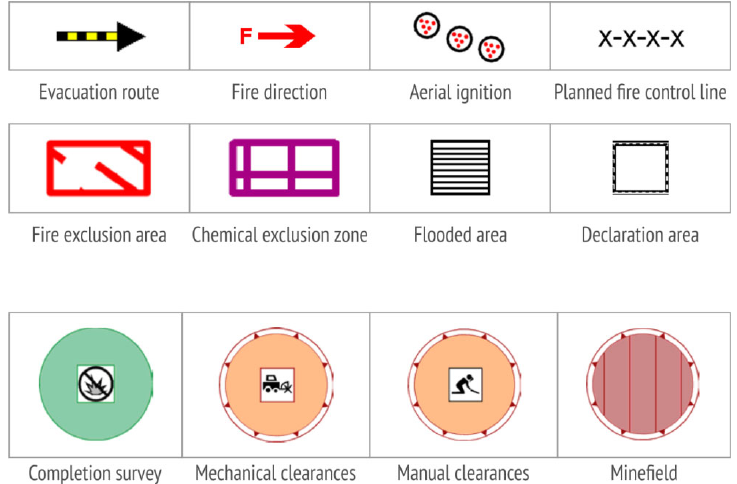
Figure 3. Examples of line (top) and area (middle) symbols from Australian All Hazard Symbology, and area symbols from Humanitarian Demining Map Symbols (bottom).